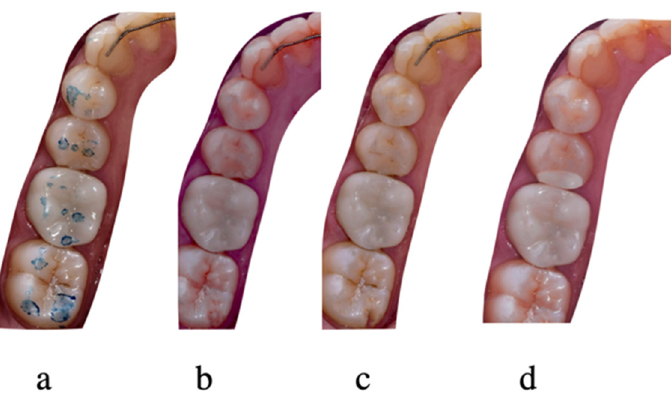
Figure 4. MZC evaluated at 1 week ( a ), 6 months ( b ), 1 year ( c ) and 2 years ( d ).